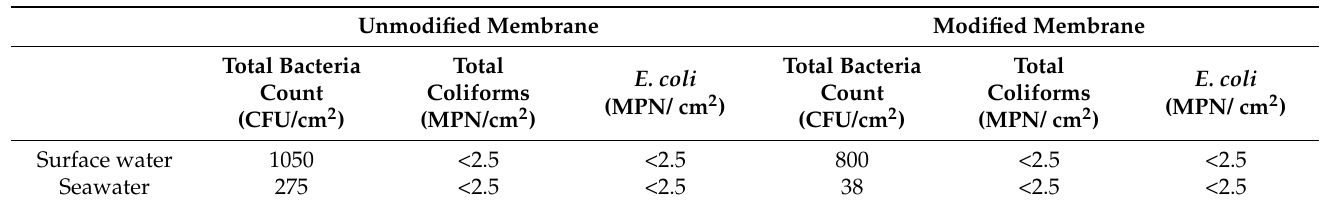
Table 2. Adhesion of microorganisms present at occurrence levels in surface and sea water onto the membrane surface of modified and unmodified membranes.